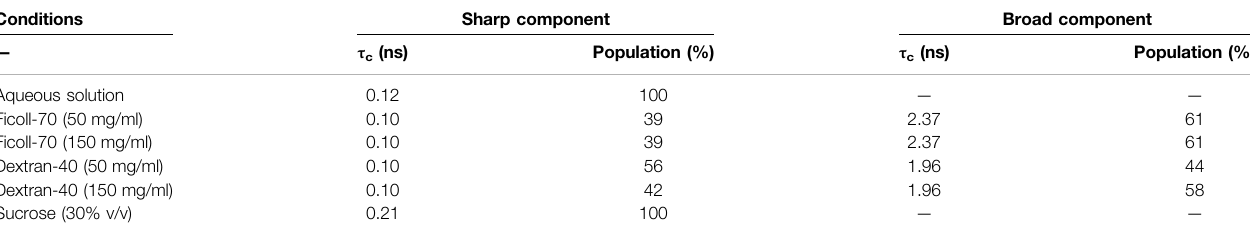
TABLE 2 | Correlation times ( τ c ) and component percentage (%) of the N72C-MTSL EPR spectra recorded under different solution conditions at 25 ° C a . Conditions Sharp component Broad component τ — τ c (ns) Population (%) c (ns) Population (%) Aqueous solution 0.12 100 — Ficoll-70 (50 mg/ml) 0.10